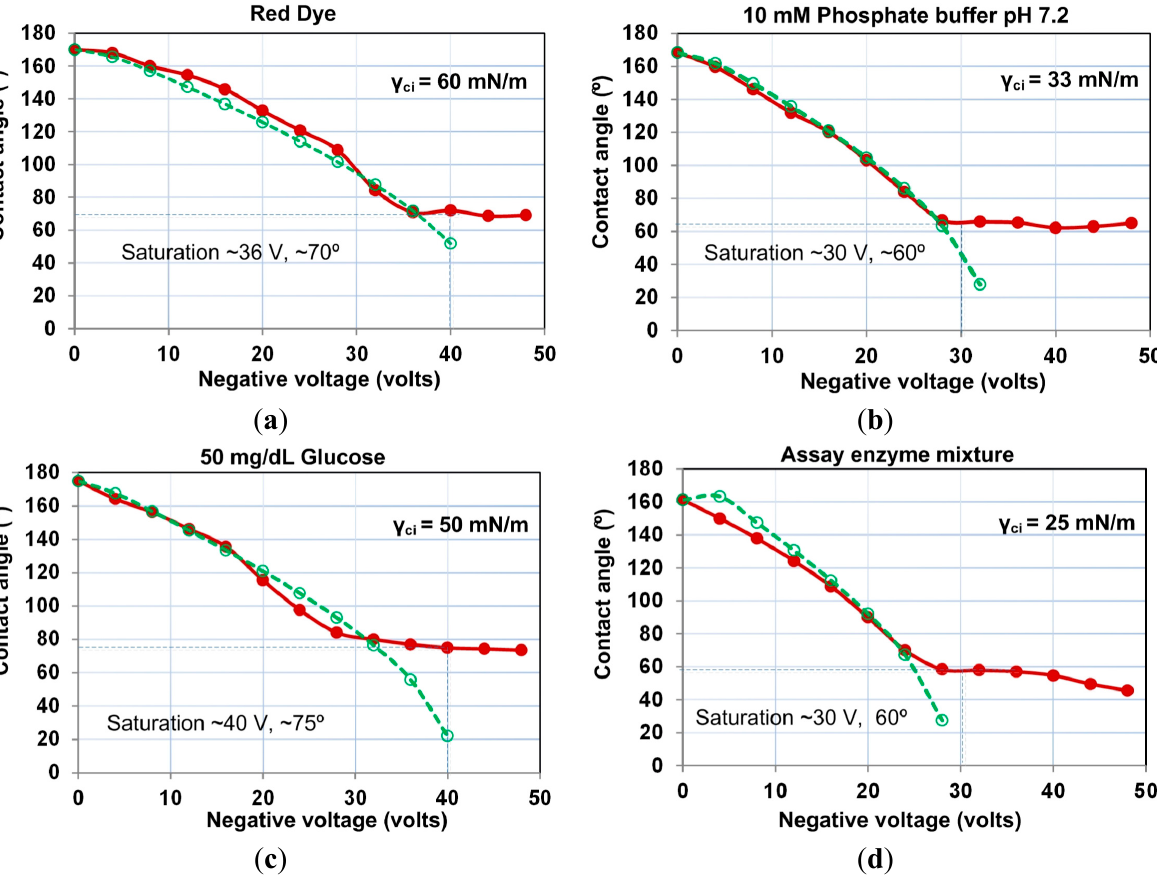
Figure 3. Electrowetting characterization of: ( a ) red dye; ( b ) 10 mM phosphate buffer, pH 7.2; ( c ) 50 mg/dL glucose; ( d ) assay enzyme mixture. The saturation angle varied between 60° and 75°. The dashed lines show the predicted values using the Lippmann equation, and the solid line indicates experimental observations. The maximum voltage for saturation was 40 V. Since all of the reagents saturate below this voltage, the operating point was chosen as 40 V for all